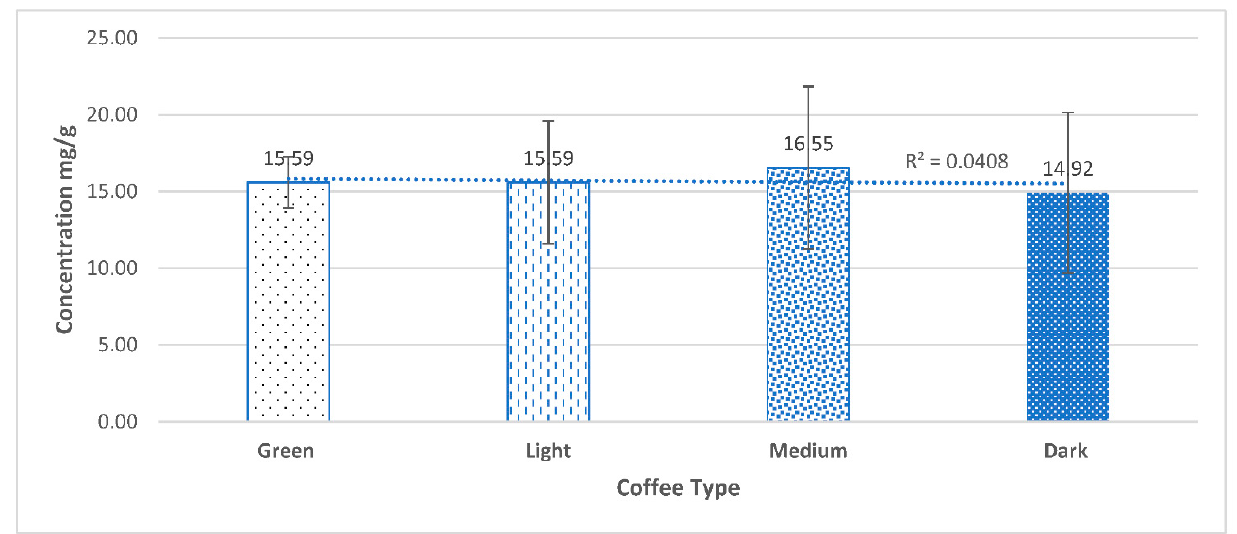
Figure 1. The average total phenolic content (mg/g GAE) for each roasting degree with (different geographical origin). No correlation was found between roasting degree and total phenolic content. (R 2 = 0.041). Results are statistically insignificant with a p -value > 0.05.